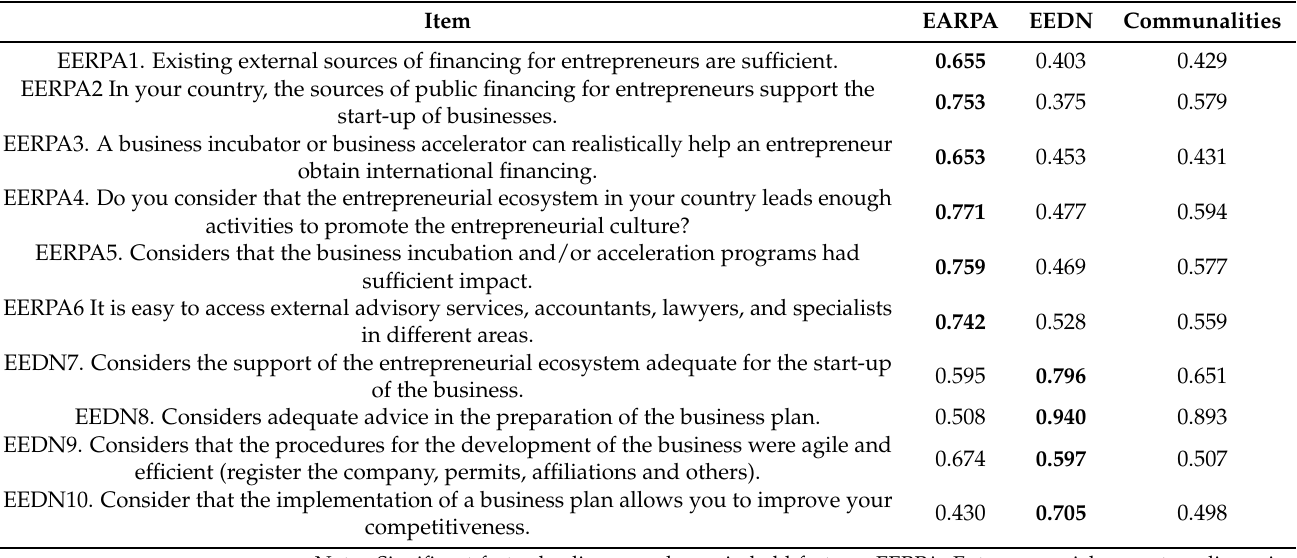
Table 2. Exploratory factorial analysis for the Entrepreneurial Ecosystem Perception scale ( n = 216). Item EARPA EEDN